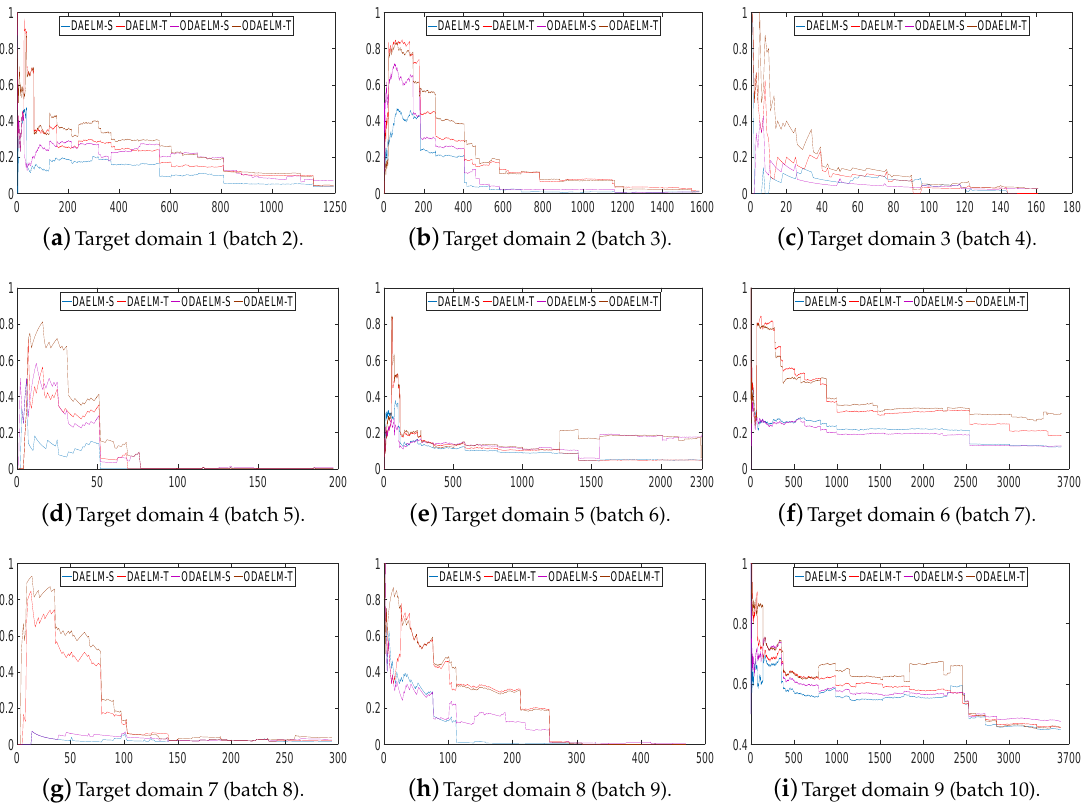
Figure 7. Classification errors on nine target domains using setting 1. The y -axis represents the error rate, in which 1 equals 100%. The x -axis is the number of samples arrived. The proposed methods and their batch learning versions are plotted in different